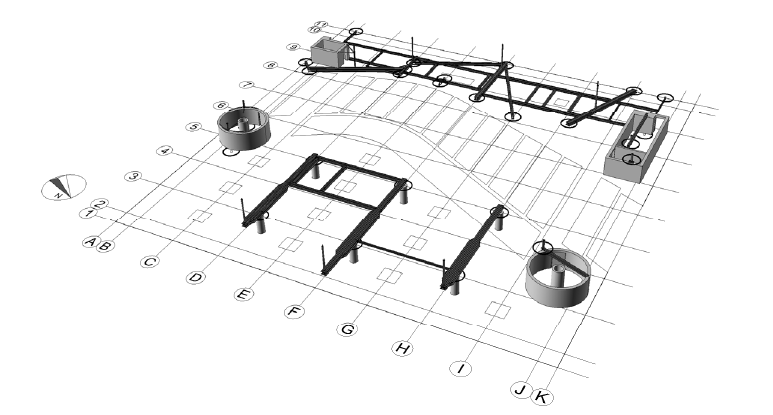
Fig. 3: The load distributing structure on top of the AroS